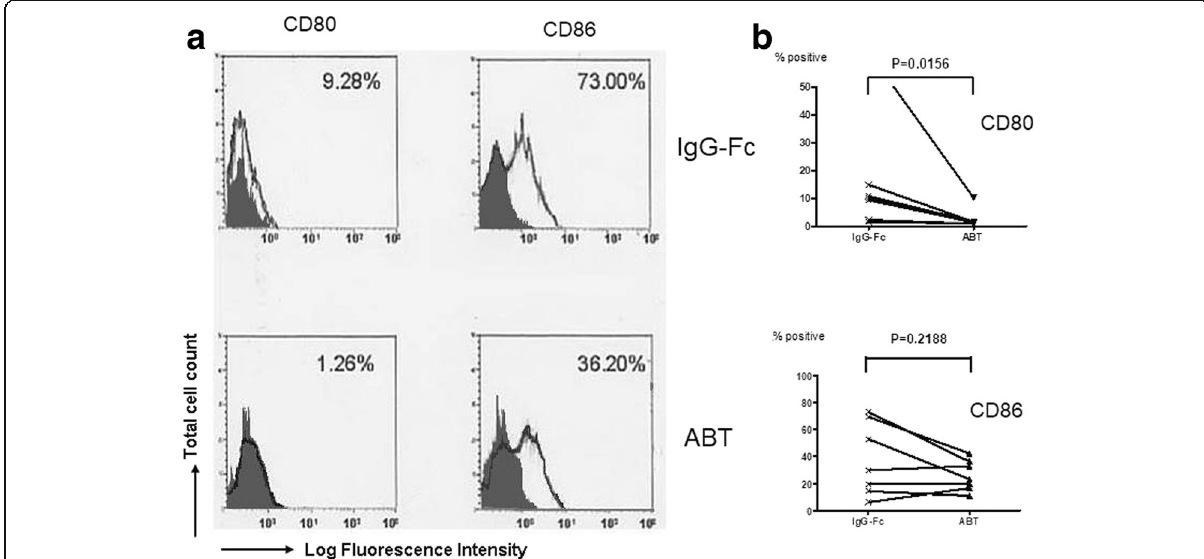
Fig. 3 Effects of abatacept on the expression of CD80 and CD86 on SEB-stimulated monocytes. Highly purified monocytes (1 × 10 6 /well) from seven healthy individuals were cultured in the presence of SEB (100 pg/ml) in each well of 24-well flat-bottomed microtiter plates with abatacept (100 μ g/ml) or control IgG-Fc (100 μ g/ml) for 48 h, after which the cells were stained with FITC-conjugated anti-CD80, anti-CD86, or control IgG1, followed by counterstaining with PE-conjugated annexin V. The cells were then analyzed by flow cytometry. a Representative histograms of the staining of various molecules on annexin V-negative monocytes. The percentages of positive cells for specific mAb staining are indicated. Stainings with isotype-matched control mAb (control IgG1) are indicated by shade. b Percentages of positive cells for each specific mAb staining of monocytes from seven independent experiments are summarized. Statistical significance was evaluated by Wilcoxon ’ s signed-rank test